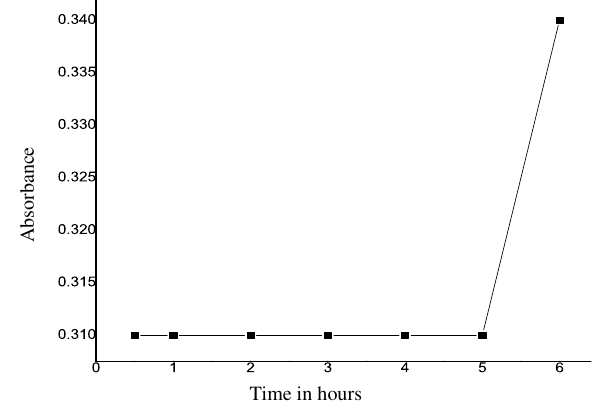
Table 2. Stability of the color of the [Dh 2+ ] [CoCl Time in hour Absorbance at 530